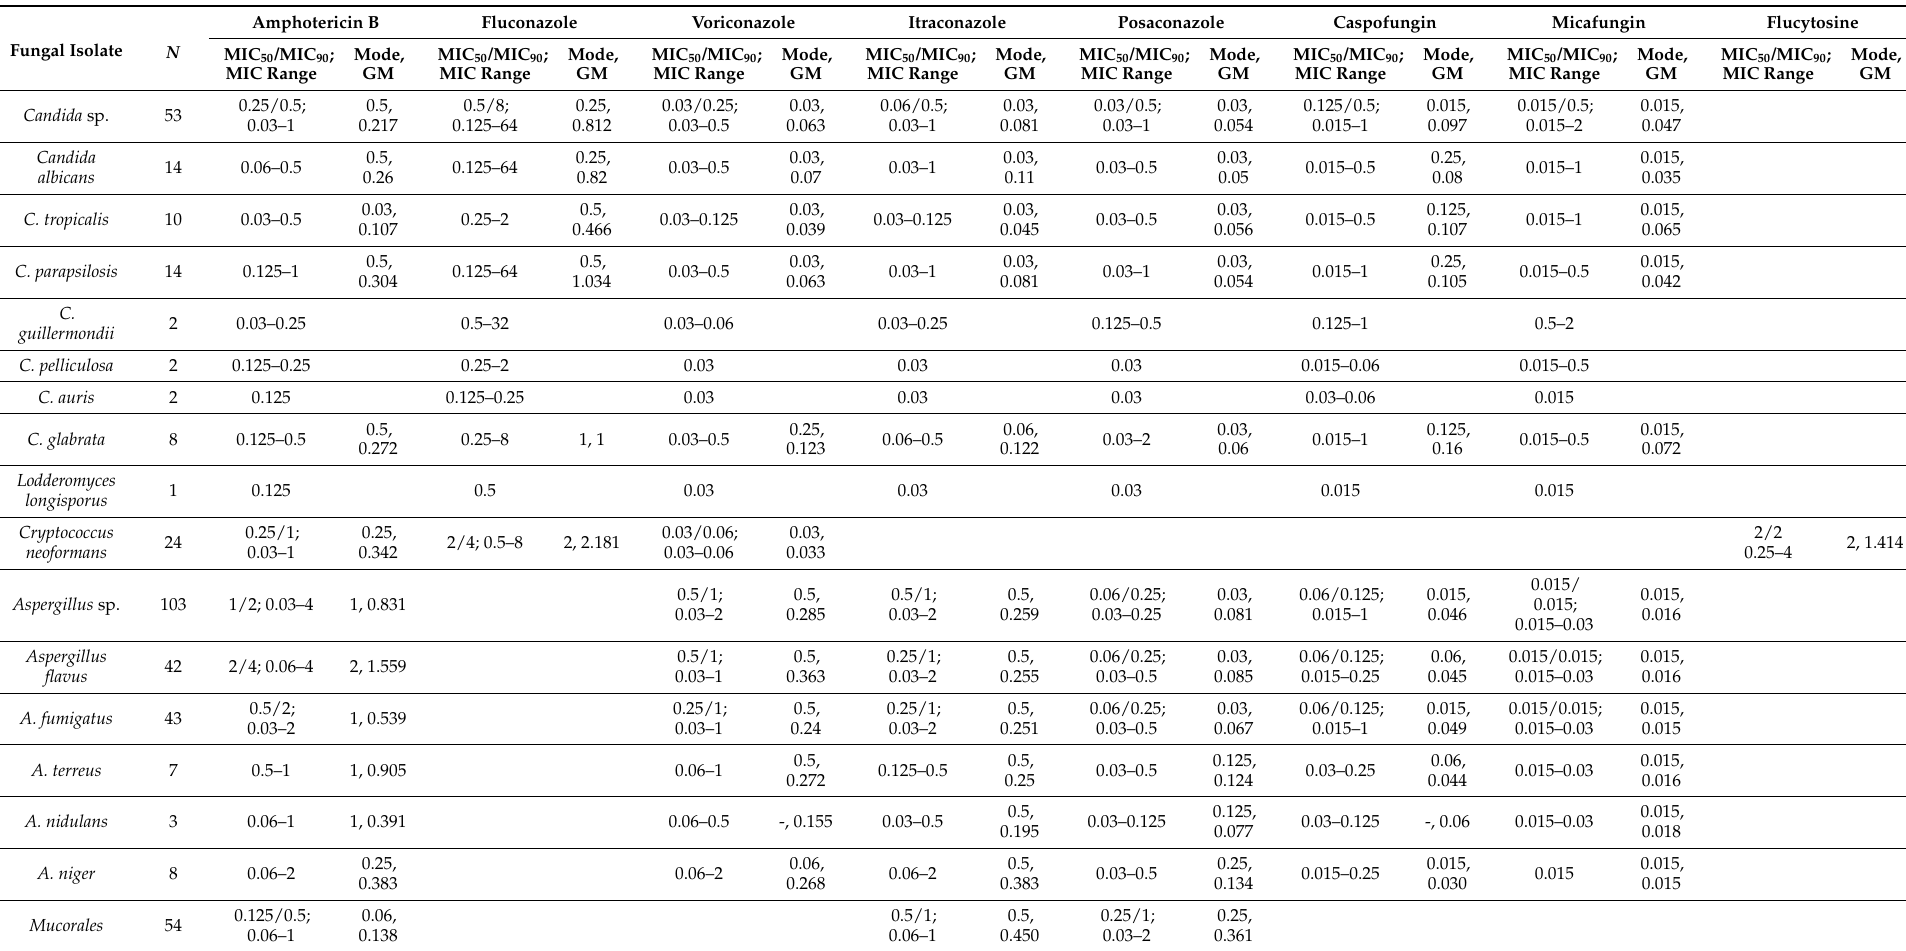
Table 4. MIC range with geometric mean, mode, MIC 50 , and MIC 90 values for the different fungal species from IFI cases by CLSI